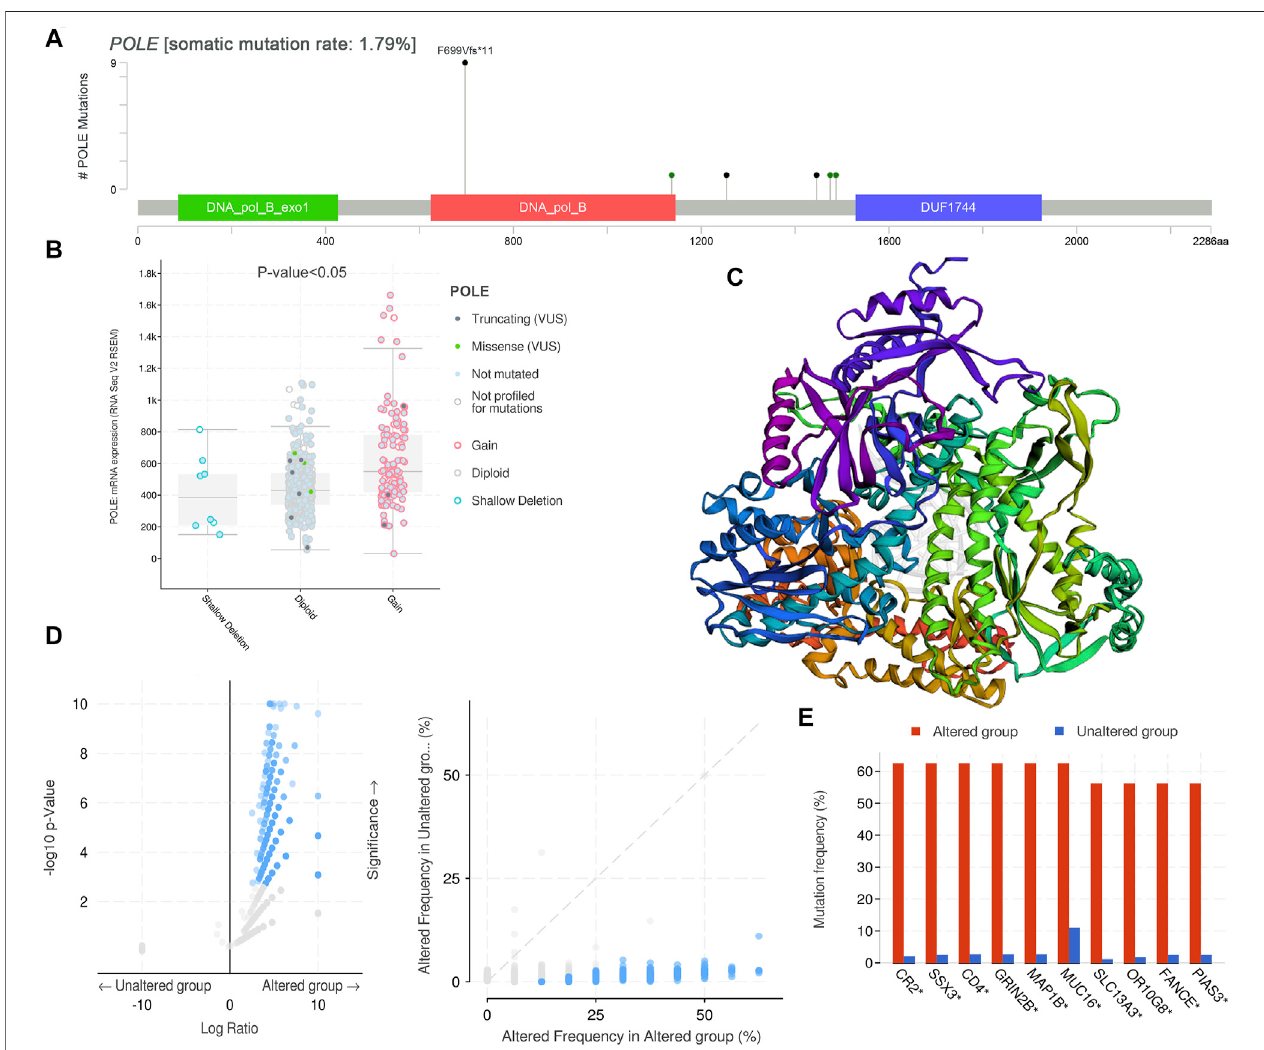
FIGURE 4 | DNA variation landscape of polymerase epsilon (POLE) mutation pro fi les in clear cell renal cell carcinoma (ccRCC). (A) The mutations mainly occur in exon DNA_pol_B and some introns. (B) The expression of POLE was signi fi cantly increased in the gain group, the expression of POLE in diploid cells was lower, and mRNA expression levels were signi fi cantly decreased in the POLE shallow-deletion gene group. (C, D) Screening for signi fi cant difference in gene expression between POLE-alteredandPOLE-unalteredgenes. (E) Thetop10upregulated genesrankedbymutationfrequencyareCR2,SSX3,GRIN2B, MAP1B,MUC16,SLC13A3, OR10G8, FANCE, and